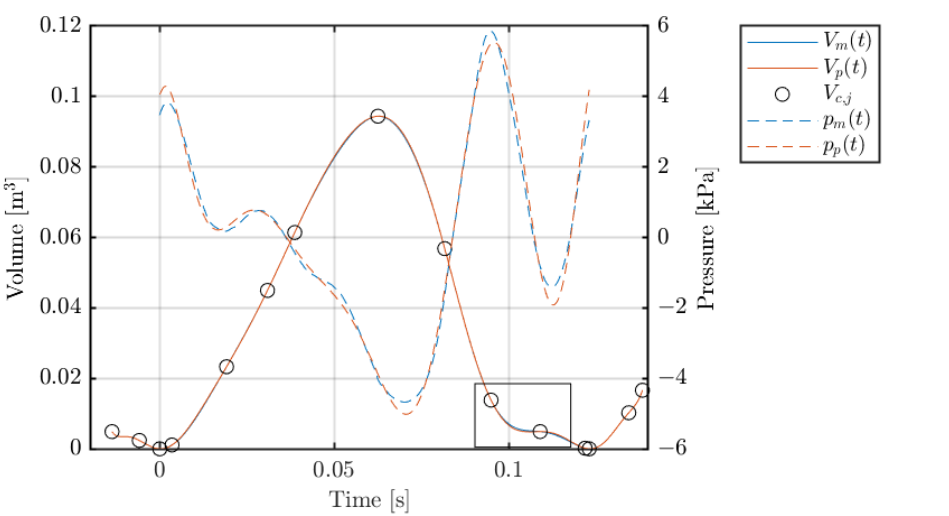
Figure 2. Mean signals (blue) as in Figure 1 with the control points ( ◦ ) for the volume model and the resultant polynomial function with the corresponding sound pressure (orange) for 96.5